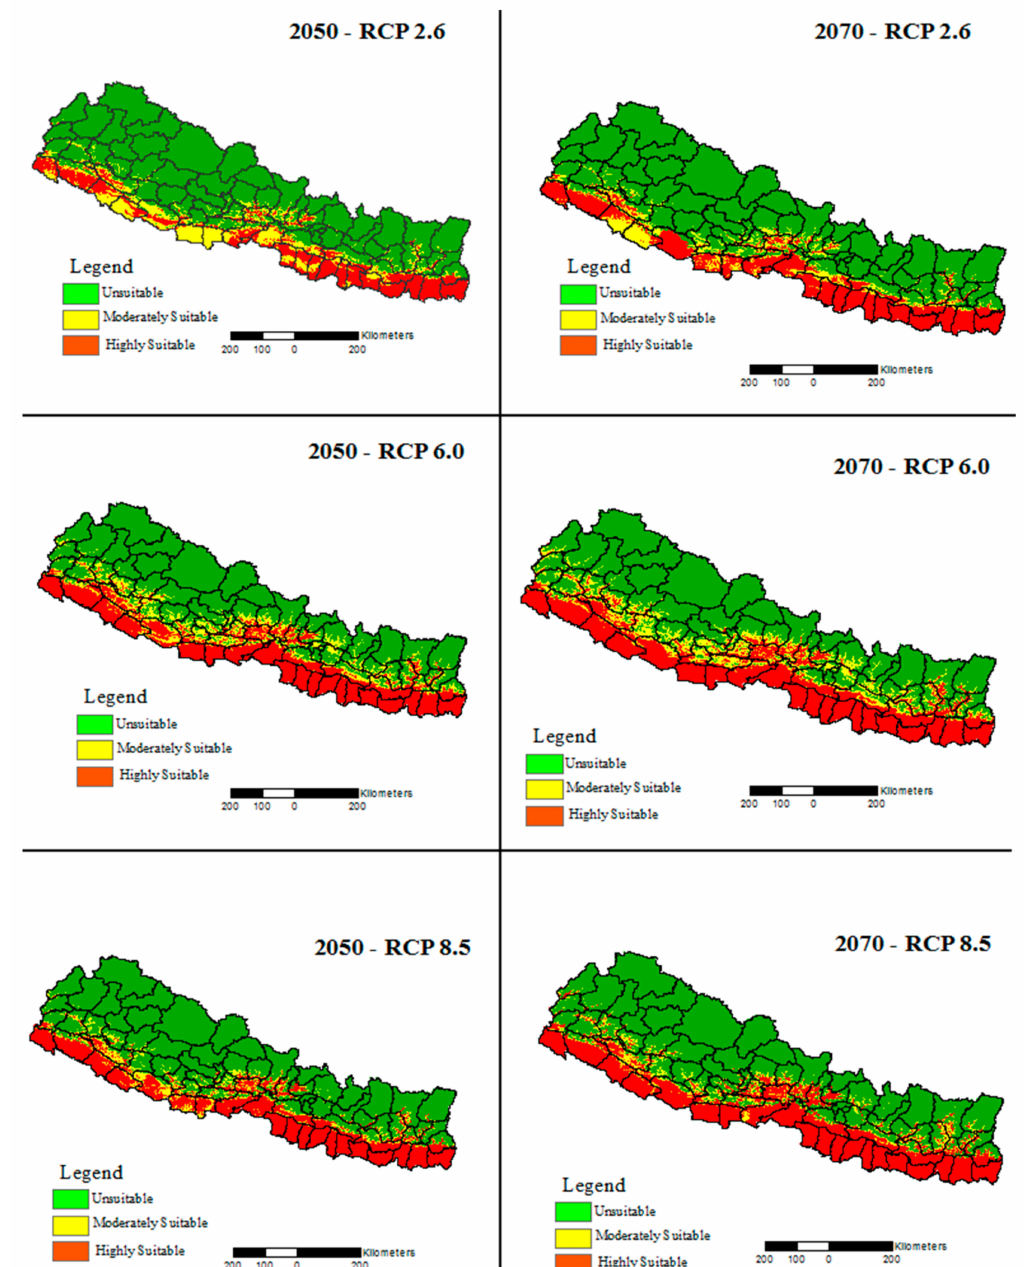
Figure 6. Spatial distribution of future climatically suitable areas of dengue fever in Nepal in 2050s and 2070s under the various greenhouse gas emission